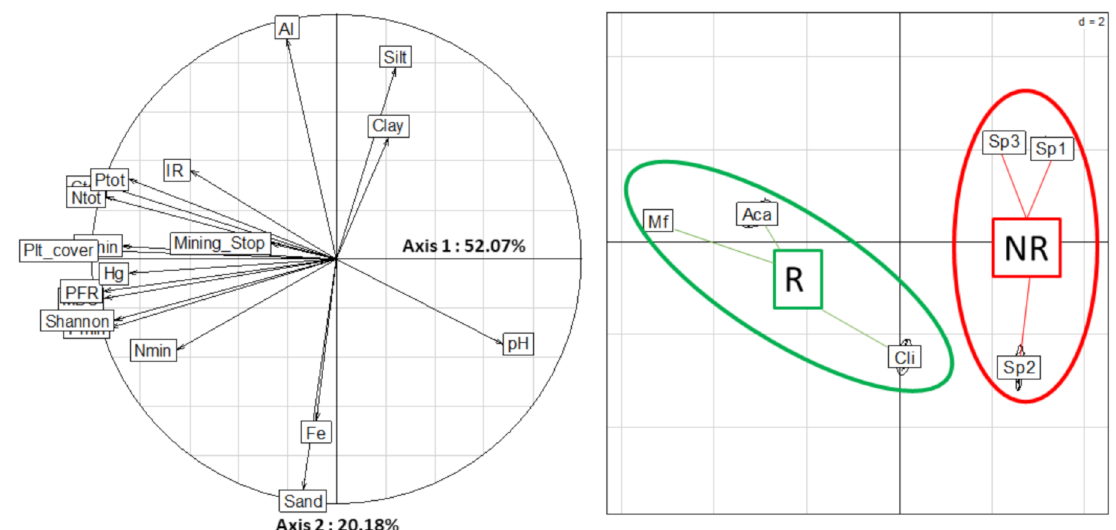
Figure 2. Principal component analysis on the most explanatory variables and representative of the variability of the database. ( Left ): projection of dataset variability plotted on a factorial map of the first two discriminating axes according to site factor: Sp1, 2 and 3. Spontaneous vegetation, Cli: monoculture of C. racemosa , Aca: monoculture of A. mangium , Mf: mixed fabaceous culture. ( Right ): correlation circles plot with variable vectors (MBC, C/N/P mineralization, total CNP, total Al/Fe/Hg, clay, silt, sand, pH, PFR, IR, Shannon Index, Mining_stop—number of years after mining stopped, Plt_cover—approximate percentage of vegetation cover (according to the classification of Tropical Ecosystem Environment Observations) for each respective factor. Eigen values 52.07%, 20.18% for axes 1 to 2, respectively. Randtest: simulated p -value: